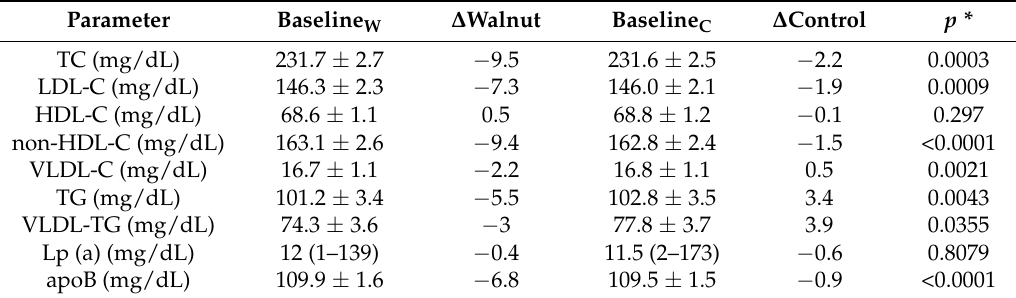
Table 2. Adjusted effect on fasting lipids, apolipoprotein B (apoB) and lipoprotein (a) (Lp (a)) (mg/dL) of intake of walnuts compared with controls in 194 subjects completing the study.